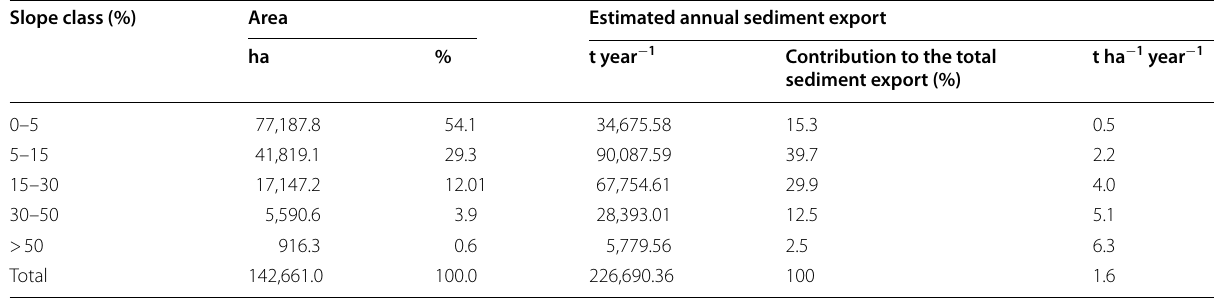
Table 11 Variation of annual sediment export rates with slope classes Slope class (%)